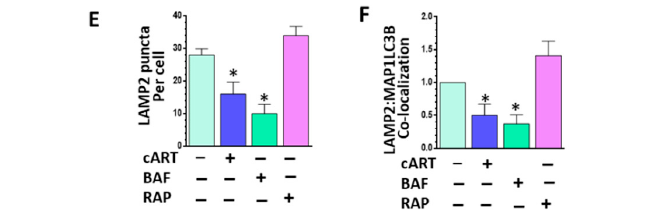
Figure 3. Exposure of microglia to cART resulted in blockade of autophagosome–lysosome fusion. ( A ) rPMs were seeded into a 12-well plate followed by tandem fluorescent-tagged MAP1LC3B plasmid. Next, cells were exposed to cART (5 µ M each of TDF, FTC, and DTG) for an additional 24 h and observed by confocal imaging. The results showed that cART exposure significantly increased the formation of autophagosomes (yellow puncta). ( B ) Representative bar graph showing the number of autophagosome (yellow puncta) per cell. ( C ) Representative bar graph showing the number of autolysosome (red puncta) per cell. ( D ) rPMs were seeded into 12-well plates followed with cART exposure for 24 h. Cells were then double immunostained with MAP1LC3B and LAMP2 antibody and observed by immunofluorescent microscopy. ( E , F ) Representative bar graphs showing cART-mediated decreased LAMP2 puncta and decreased colocalization of MAP1LC3B and LAMP2. BAF—autophagosome fusion inhibitor, and rapamycin (RAP—autophagy inducer) were used as controls for autophagy flux. Data is from three independent experiments and is expressed as means ± SEM and were analyzed using one-way ANOVA. *, p < 0.05 vs. control.